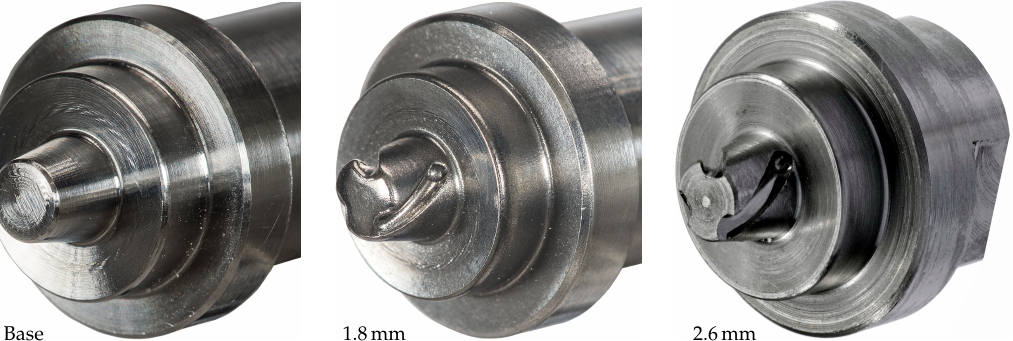
Figure 7. Development stages of the tools manufactured for verification. Base geometry without contouring, third and fifth design iterations with 1.8mm and 2.6mm structure width, respectively.